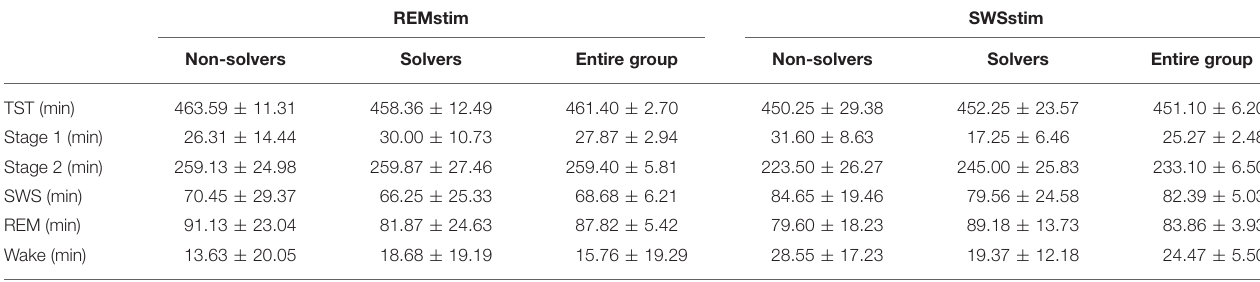
TABLE 3 | Sleep stage parameters for subjects from the REMstim and SWSstim groups separately for Solvers and